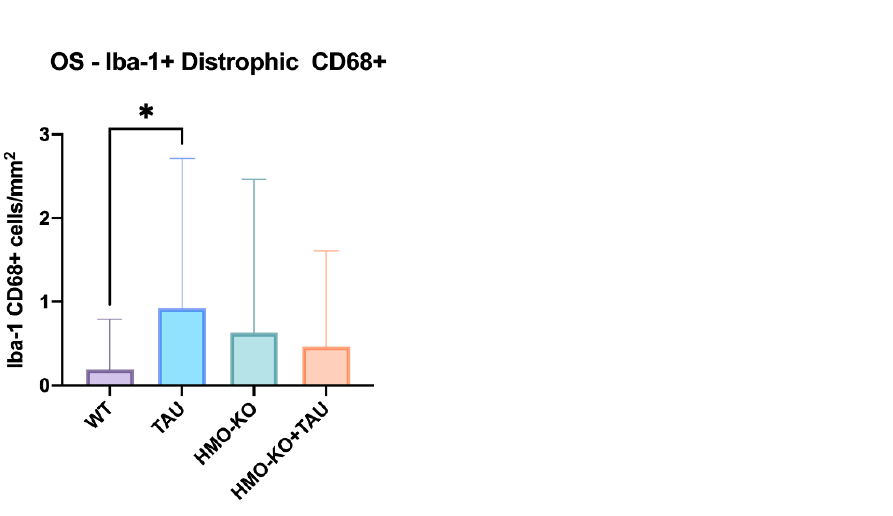
Figure 8. Number of Iba-1+/CD68+ dystrophic microglial cells per retinal area of 0.1502 mm 2 in the OS layer in each of the study groups, expressed as mean value (± SD). One-way ANOVA; * p < 0.05. Number of retinas used in the experiment: WT n = 6, HMO-KO n = 6, TAU n = 6, and HMO-KO+TAU n = 6.